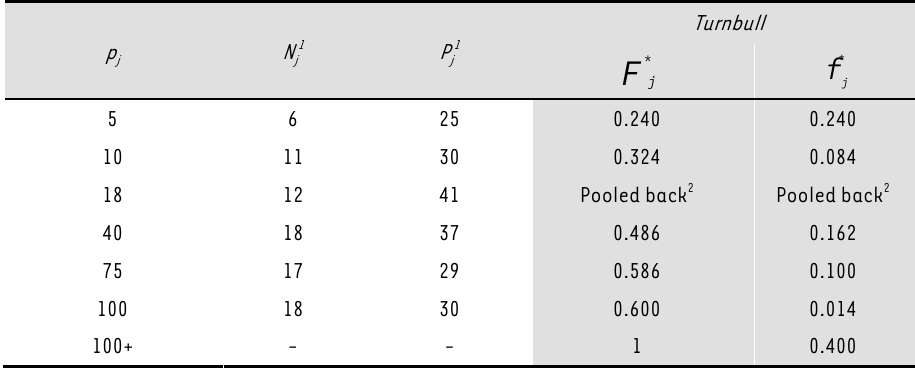
TABLE 4: Turnbull estimates with